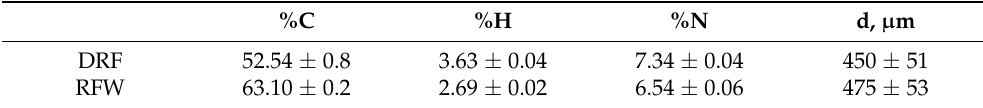
Table 1. Elemental composition and particle dimension, after milling, of dry rose flower (DRF) and rose flower waste